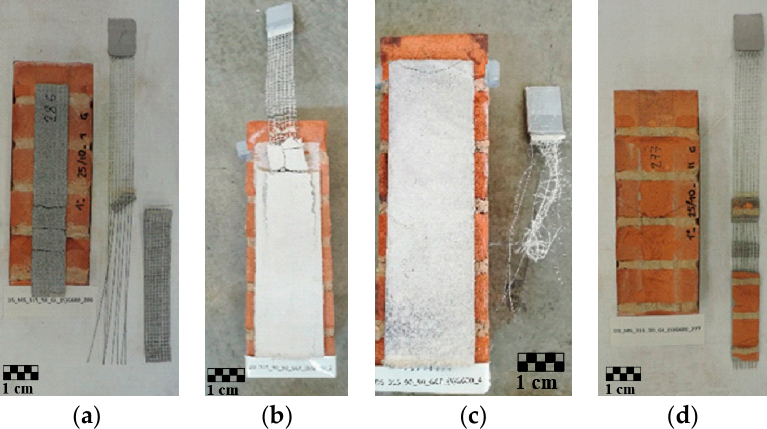
Figure 5. Failure modes of representative specimens: ( a ) interlaminar failure with debonding at the interface between the internal layer of mortar and steel fibers (MF); ( b ) partial interlaminar failure at the interface between the internal layer of mortar and steel fibers (MF*); ( c ) rupture of fibers (FR); ( d ) detachment of the SRG strip from the substrate with a thin layer of masonry attached to it (SF).